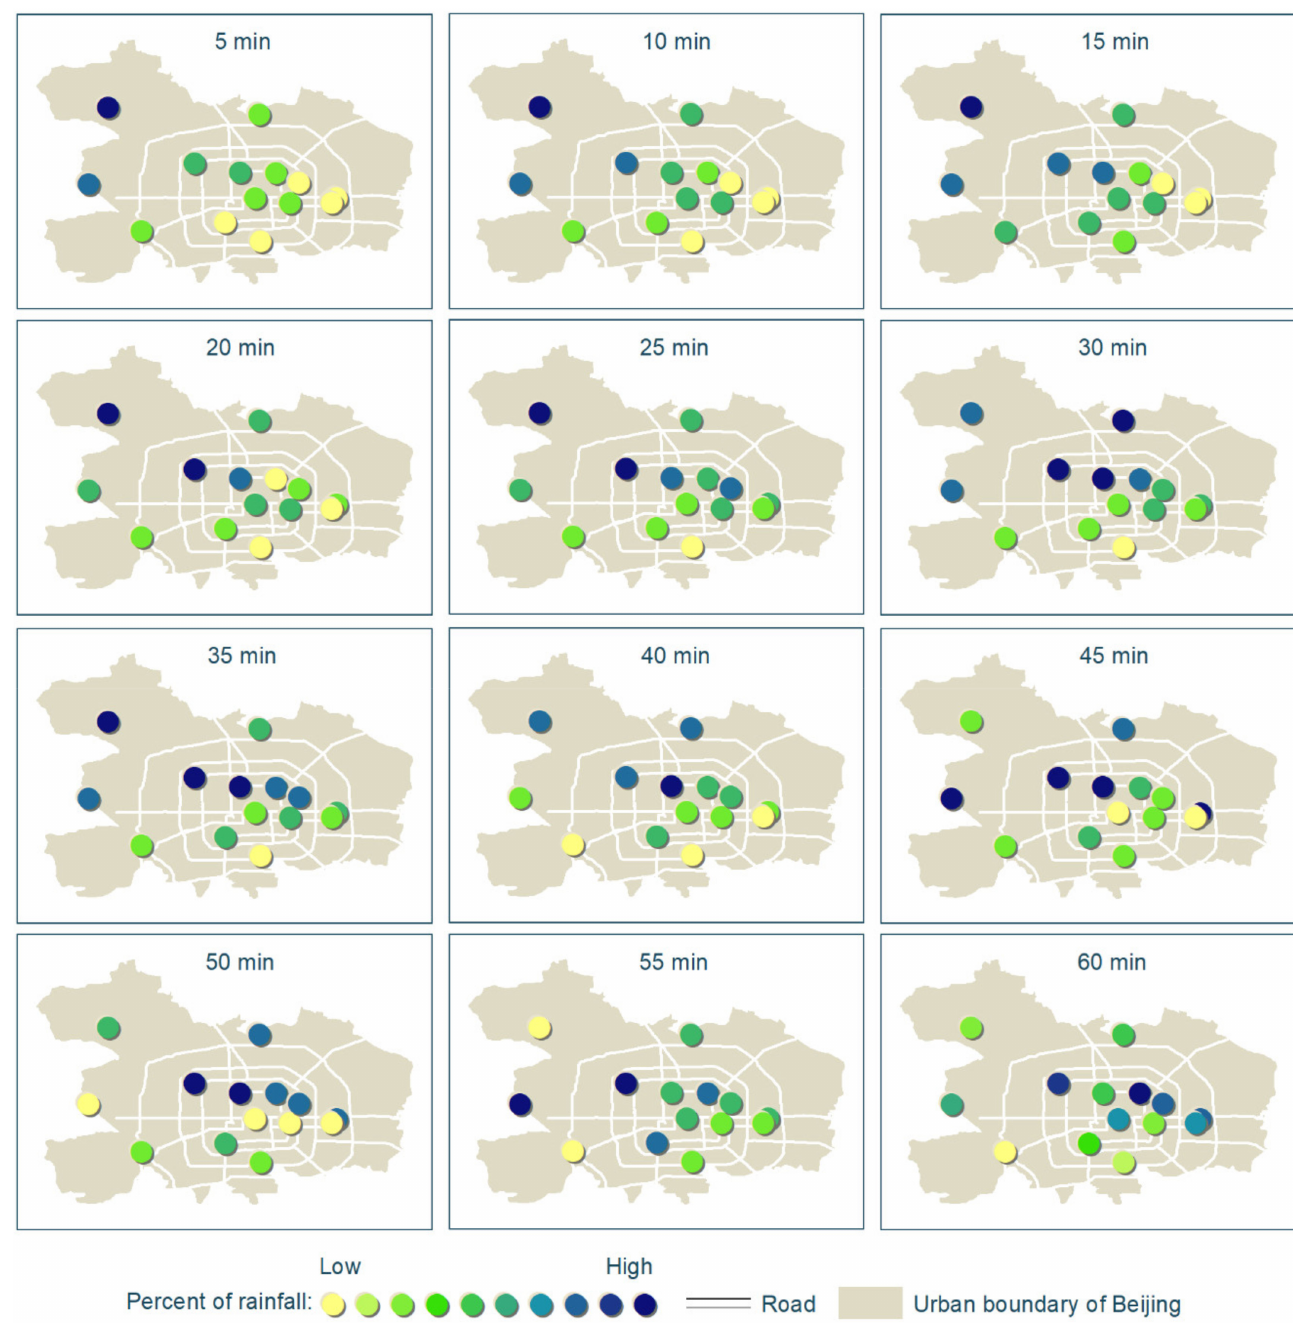
Figure 7. Spatiotemporal process of mode